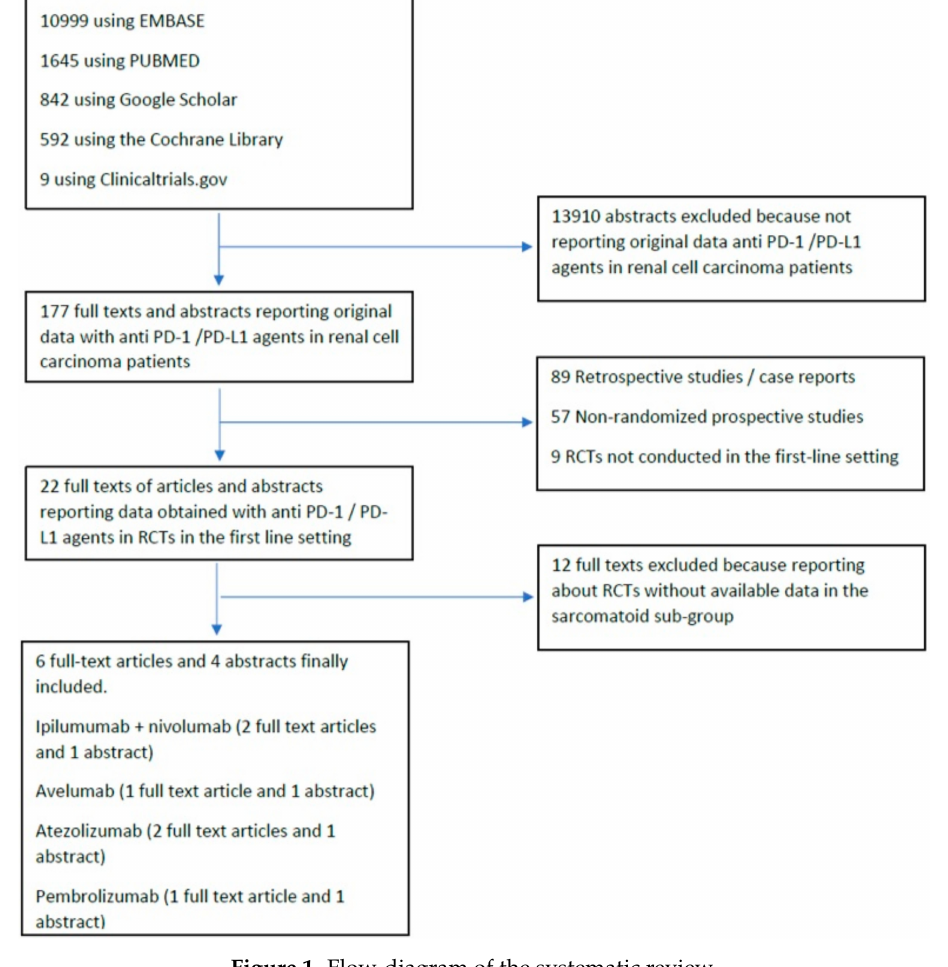
Figure 1. Flow-diagram of the systematic